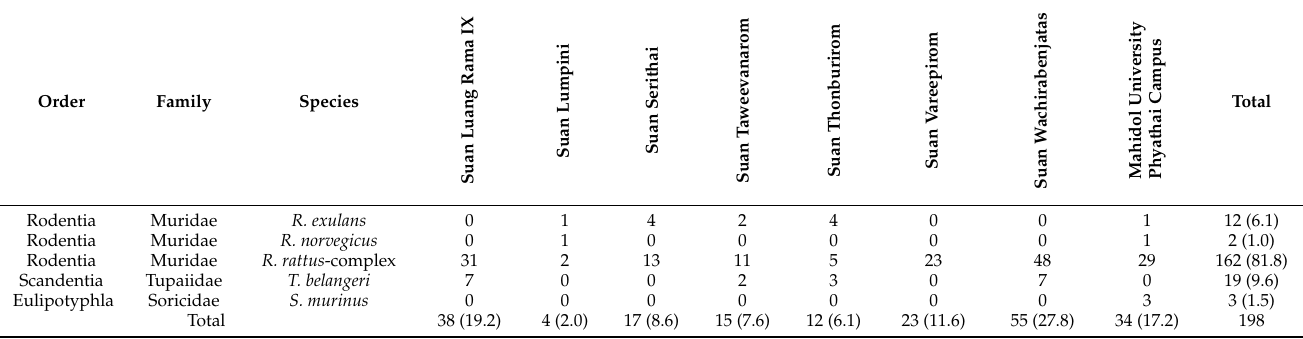
Table 1. Number of small mammals trapped from different sites in this